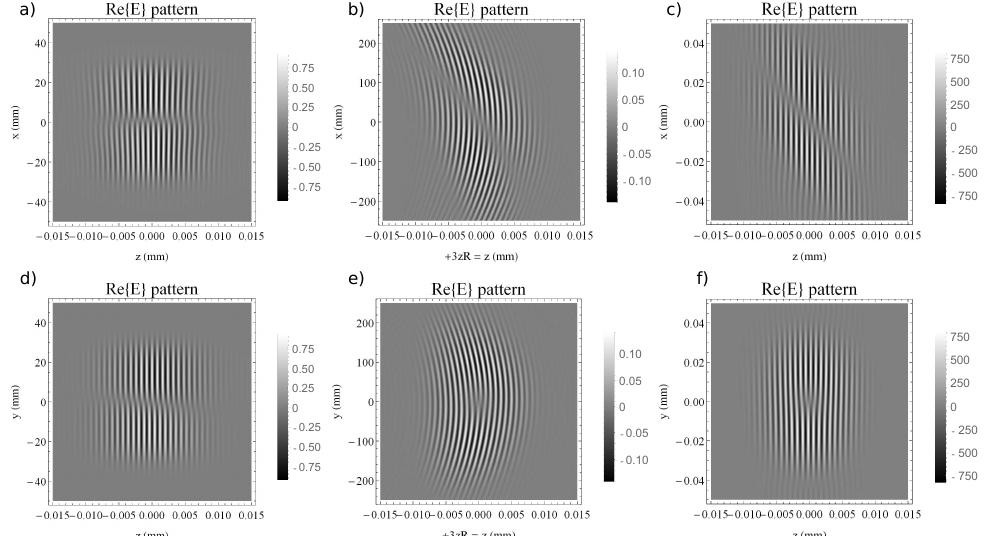
) of a laser field with SPC = 1100 mm/PHz, after being Figure 6. The electric field profile ( Re E { } − reflected by the helical mirror ( a ) on x z , in the NF ( z = 0 region), at t = 0, ( b ) in the FF at z = 3 − region, at t = 3 z R / c 0 and ( c ) in the focal region after being reflected by the helical mirror and focused · by means of an f = 1500 mm mirror (at t = 0). Similarly, Re of the same laser field, but on y E { } ( d ) in the NF ( z = 0 region), ( e ) in the FF at z = 3 z R region and ( f ) in the focal region. For simplicity, · the z coordinate at z = 3 z R and at focal plane was translated to z = 0. ·